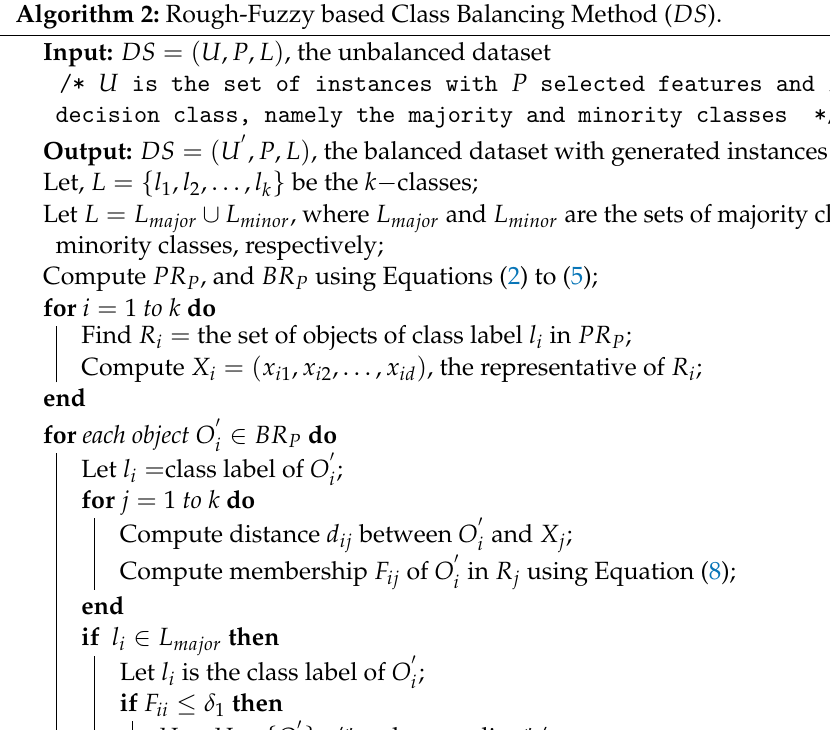
Algorithm 2: Rough-Fuzzy based Class Balancing Method ( DS